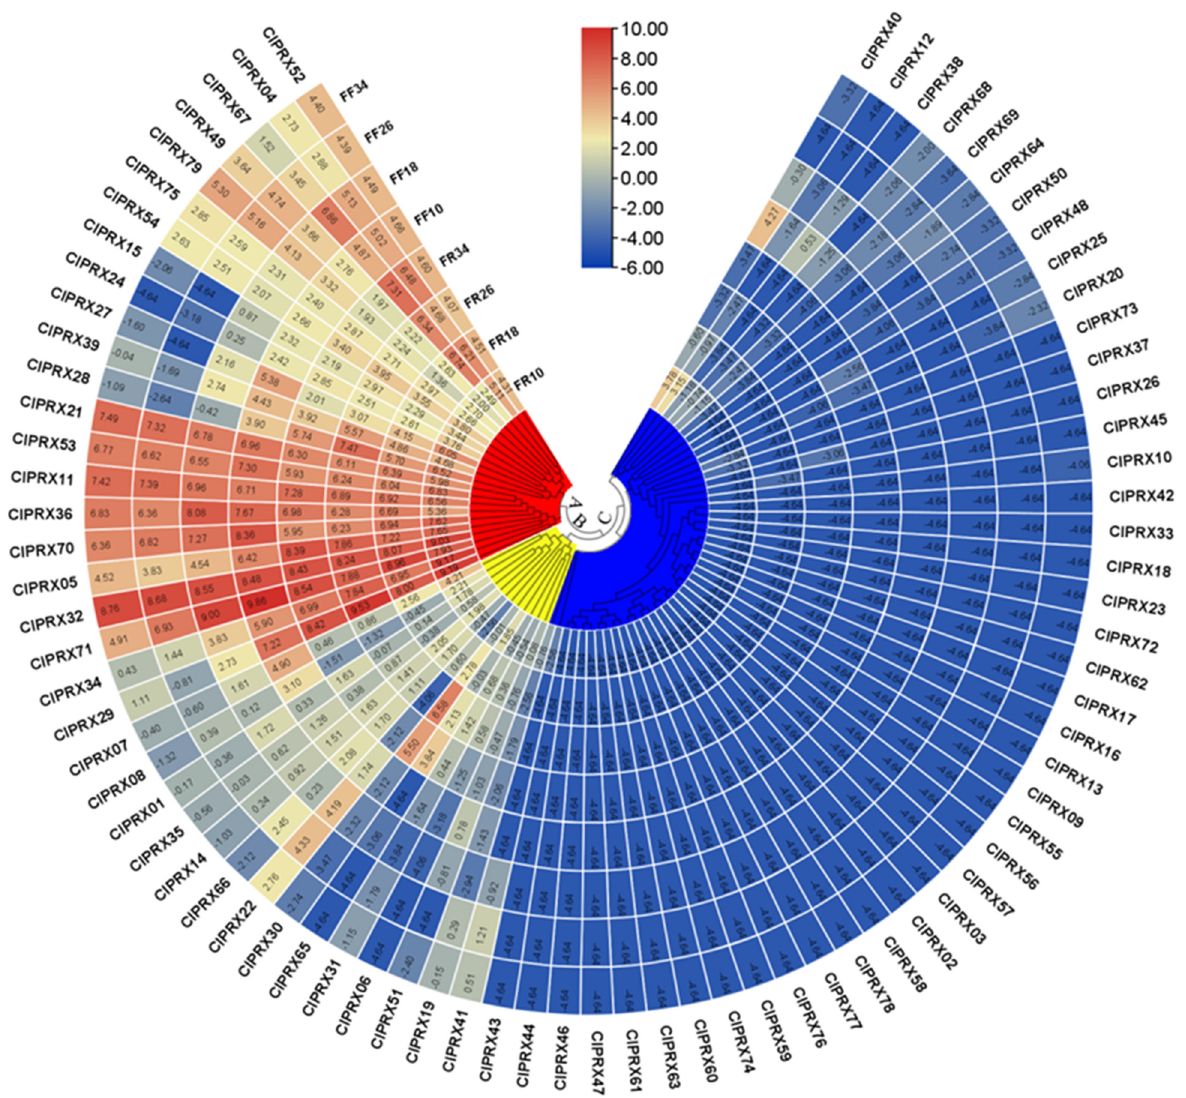
Figure 9. Expression analysis of ClPRXs in watermelon peel and flesh at different stages.